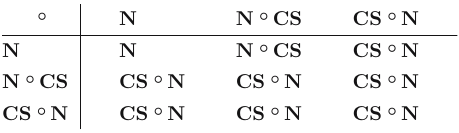
Figure 5: The Cayley table of 〈 ∘ 〉 N N CS , .